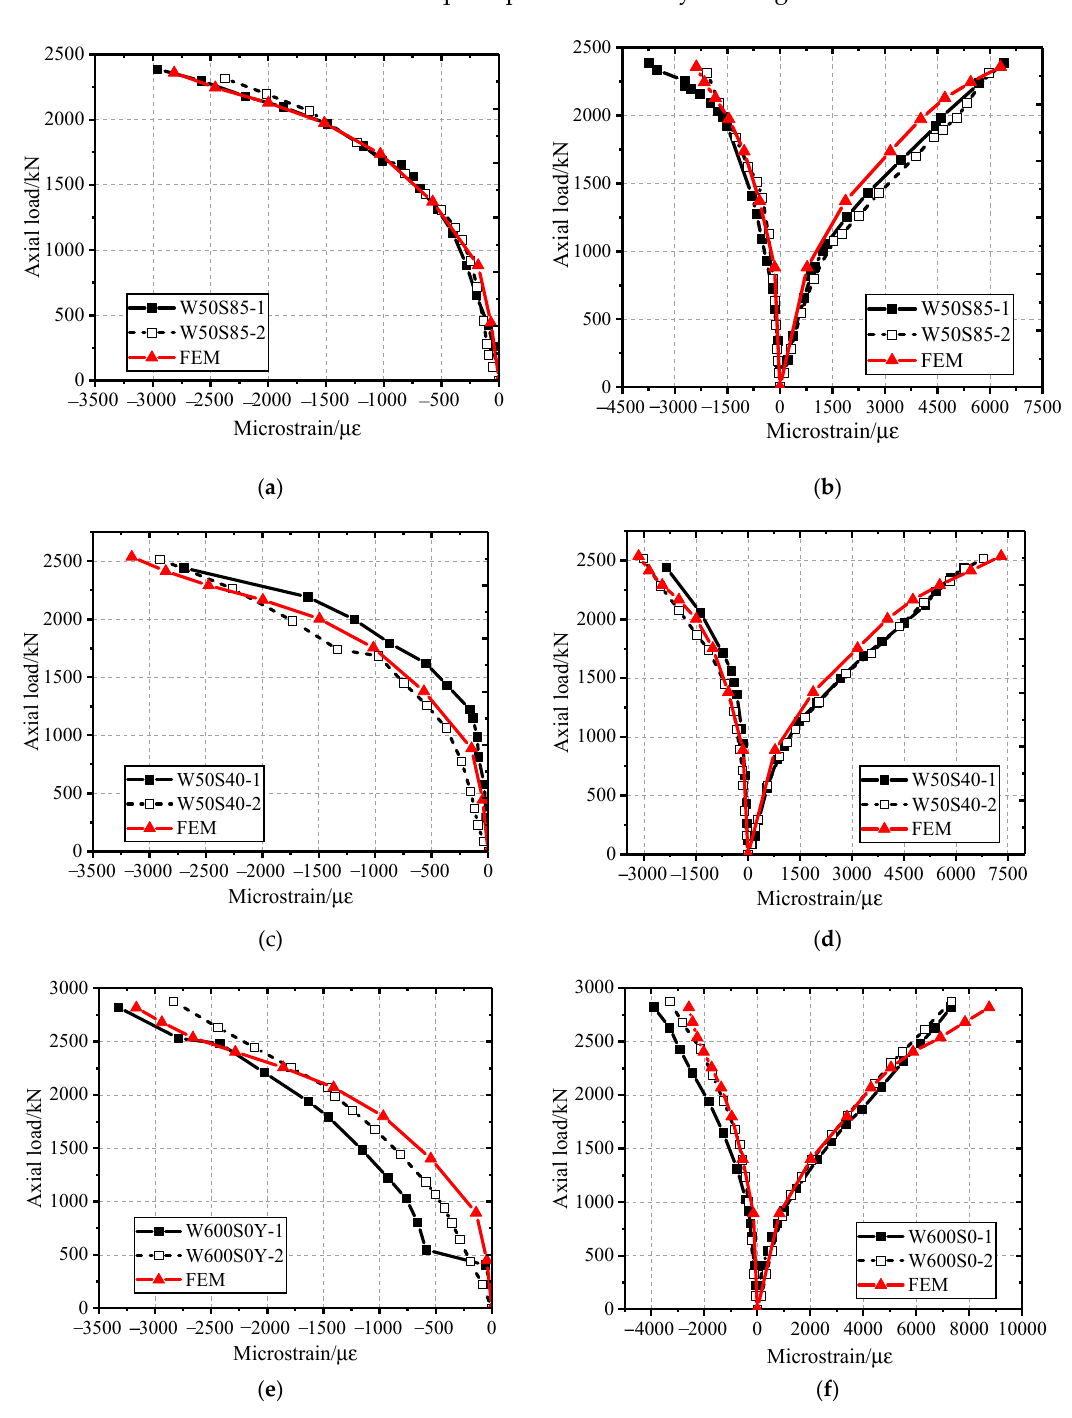
Figure 10. Comparison of the finite element calculation results with the experimental load–strain relationship curve: ( a ) W50S85-GFRP lateral strain; ( b ) W50S85-GFRP tube lateral/longitudinal strain; ( c ) W50S40-GFRP lateral strain; ( d ) W50S40-GFRP tube lateral/longitudinal strai € ( e ) W600S0-GFRP lateral strain; and ( f ) W600S0-GFRP tube lat- eral/longitudinal